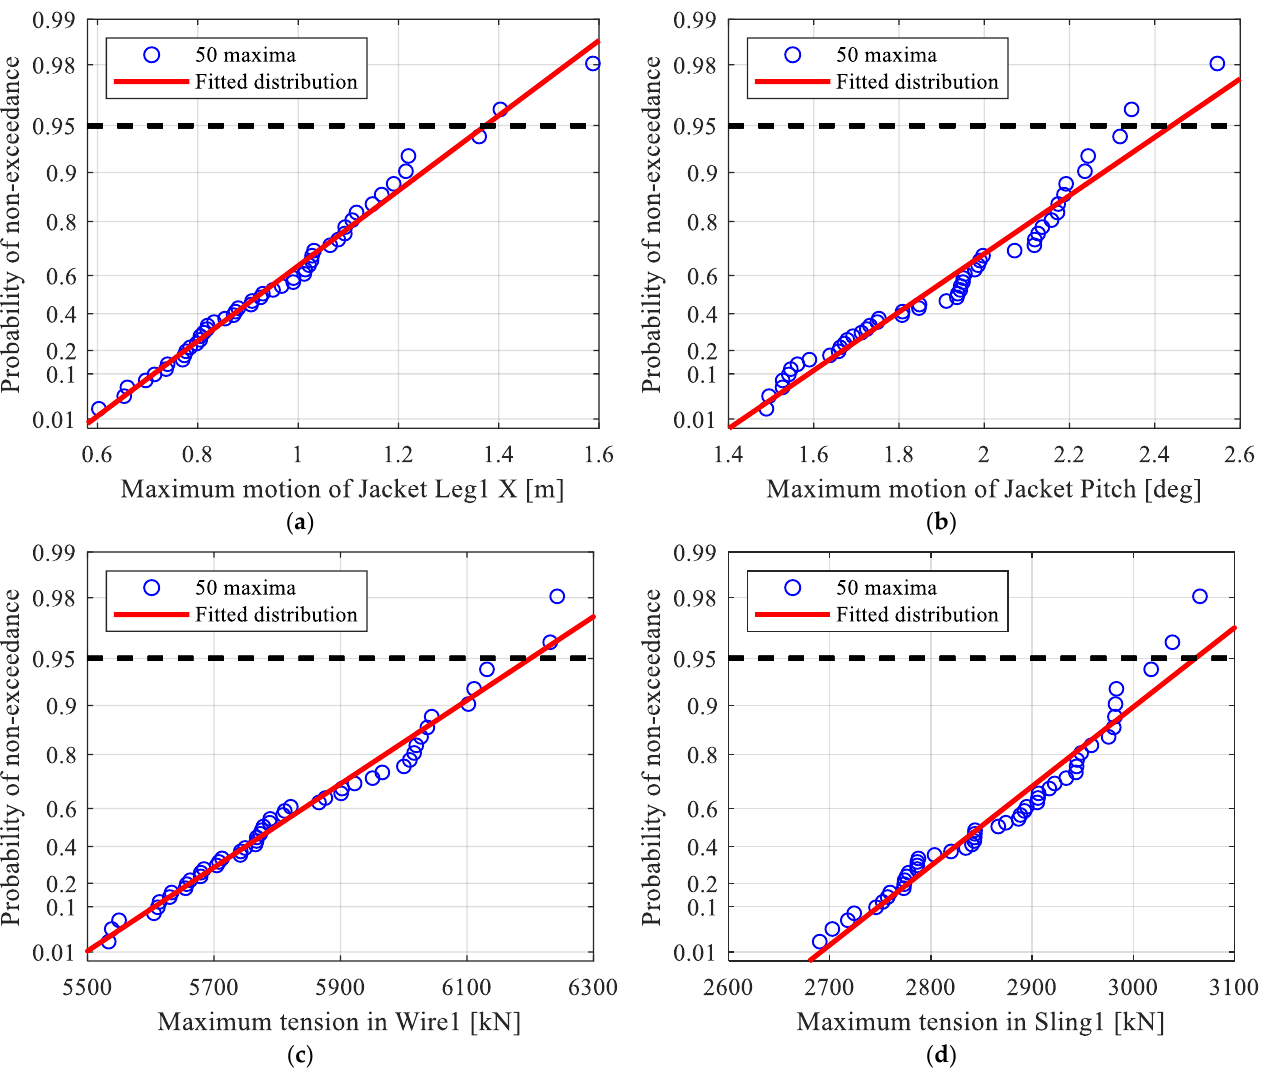
Figure 12. Fitted Gumbel distributions of extreme responses using 50 seeds. ( H s =1.5 m, T p =7 s, Dir=45 deg, JL1-Z3). ( a ) Jacket leg1 X motion; ( b ) Jacket pitch motion; ( c ) Wire1 tension; ( d ) Sling1 tension. Table 6. Extreme responses for three preliminary critical vertical